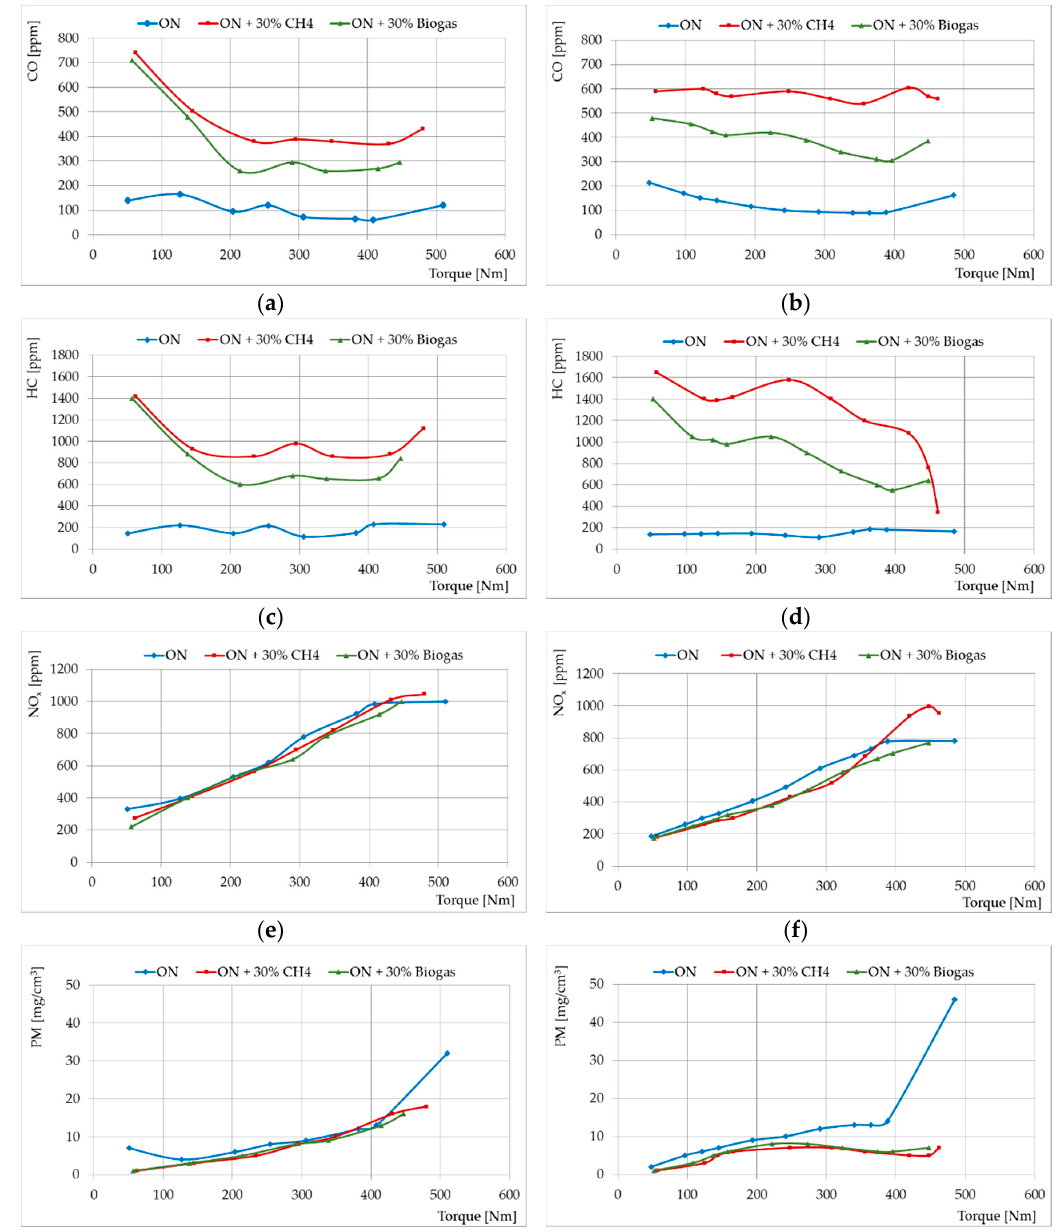
Figure 5. Emission versus torque under two crankshaft rotational speed for: ( a ) CO at 1400 rpm; ( b ) CO at 1800 rpm; ( c ) HC at 1400 rpm; ( d ) HC at 1800 rpm; ( e ) NO x at 1400 rpm; ( f ) NO x at 1800 rpm; ( g ) PM at 1400 rpm; ( h ) PM at 1800 rpm; on the base of [49–51].